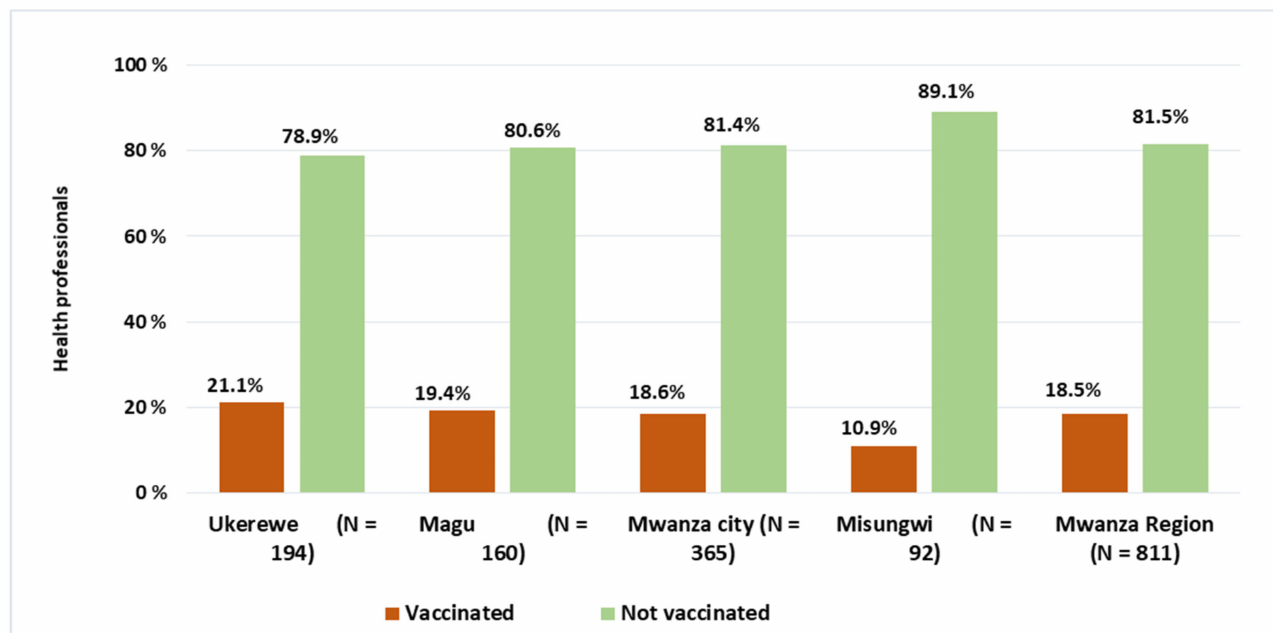
Figure 1. COVID-19 vaccine status among health professionals.